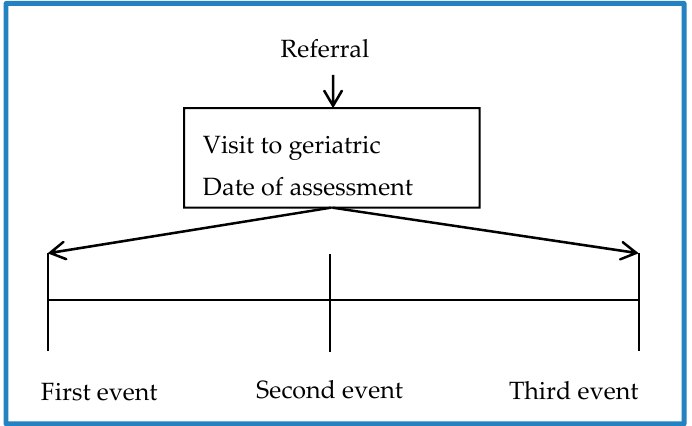
Figure 1. Study timelines.